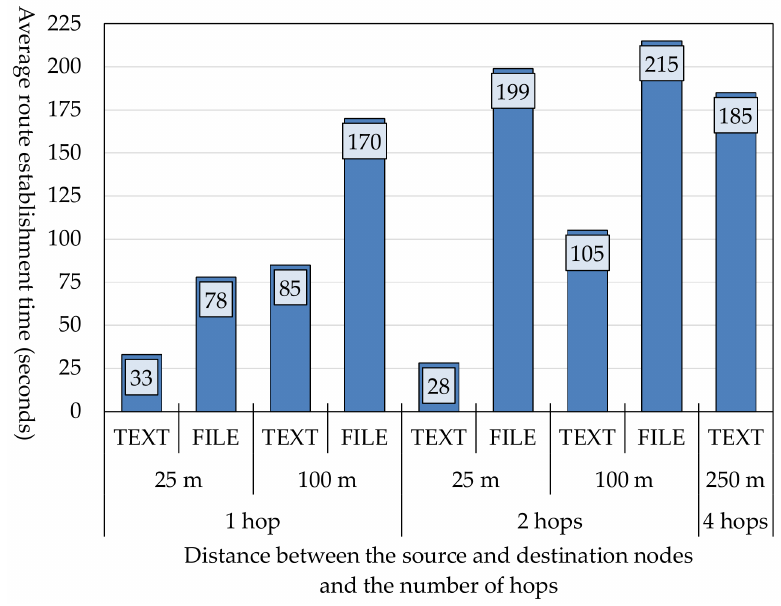
Figure 13. Data exchange